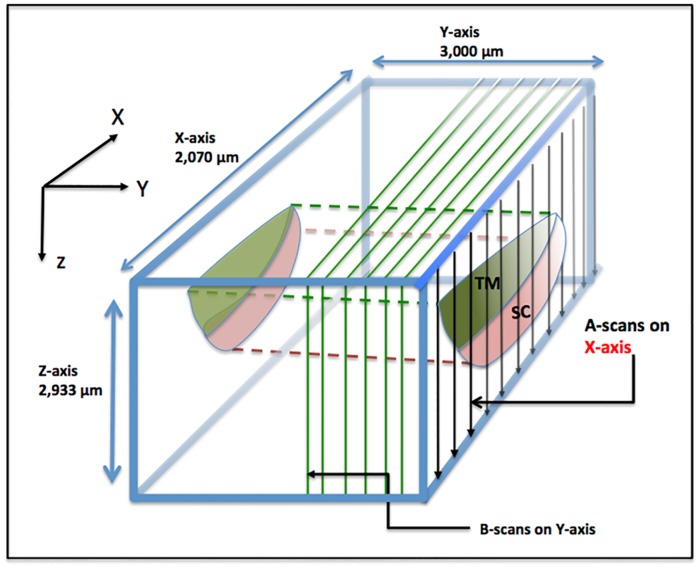
Schematic illustration of the OCT scanning protocol.B-scans are performed as a parallel series of sequential cross sections along the Y-axis, which represents the circumferential direction along Schlemm’s canal. A-scans are performed sequentially along the X-axis in the plane of the B-scan. The A-scans traverse along the Z-axis from the trabecular meshwork surface to the surface of the sclera with each A-scan oriented orthogonal to the X-axis. Scanning dimensions in each axis are as indicated.